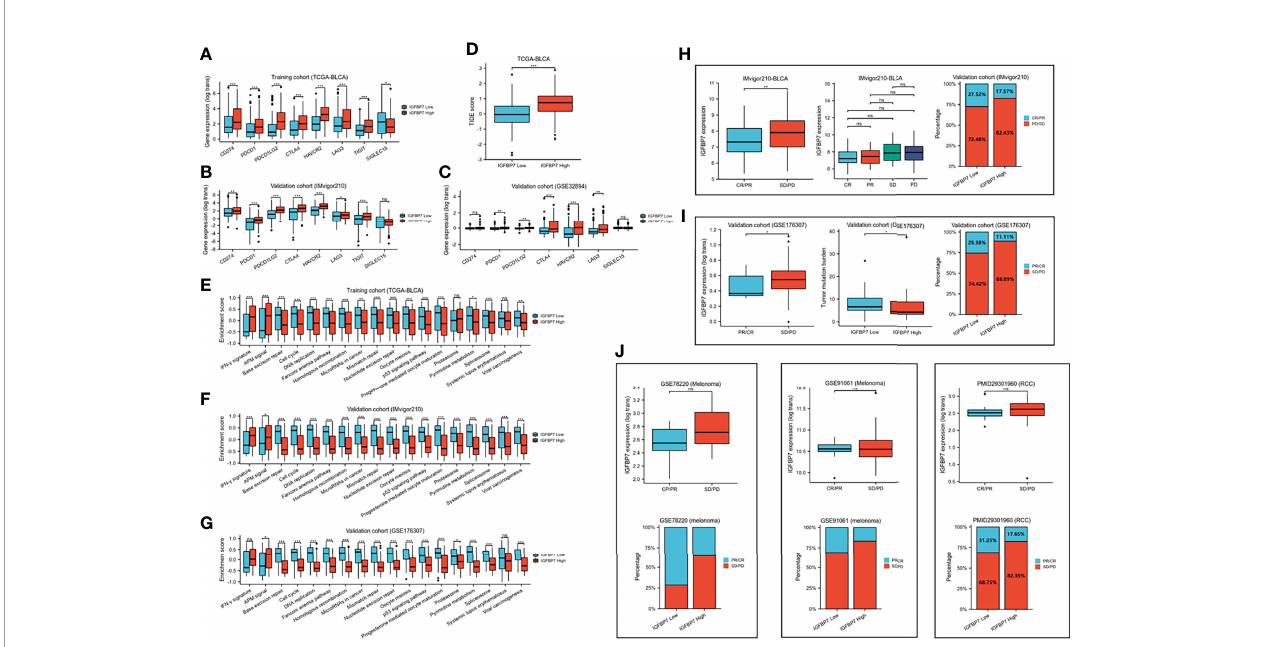
FIGURE 4 | IGFBP7 predicts therapeutic response to immunotherapy in BLCA. (A – C) Expression levels of immune check points in the high- and low-IGFBP7 groups in the TCGA, IMvigor210, GSE32894 cohorts. (D) ICB responses in the high- and low-IGFBP7 groups using TIDE algorithm. (E – G) The enrichment scores of several immune-related signatures in the high- and low-IGFBP7 groups. (H, I) Correlation between IGFBP7 and the clinical response of cancer immunotherapy in the IMvigor210 and GSE176307 cohort. (J) Correlation between IGFBP7 and the clinical response of cancer immunotherapy in the RCC cohort and two melanoma cohorts. CR: complete response; PR, partial response; PD, progressed disease; SD, stable disease. (CR/PR means patient who are CR or PR; SD/PD means patient who are SD or PD). *p< 0.05; **p<0.01; ***p<0.001. ns, no signi fi cance; ns, p ≥